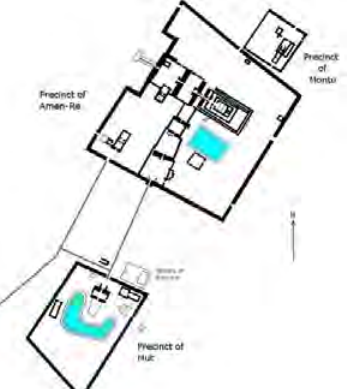
Figure 4. Map of Karnak, showing major temple complexes and sacred crescent lake of